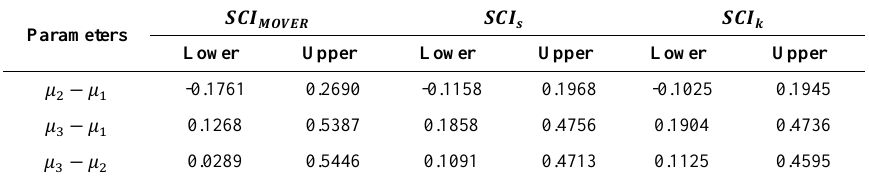
Table 4. The 95% SCIs for the difference between means of normal distributions with known